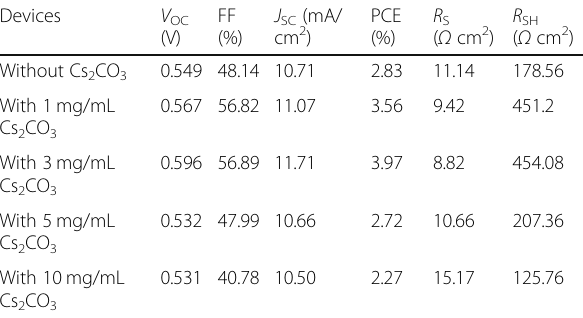
Table 1 Summary of device performances according to different Cs 2 CO 3 concentrations under AM 1.5G condition